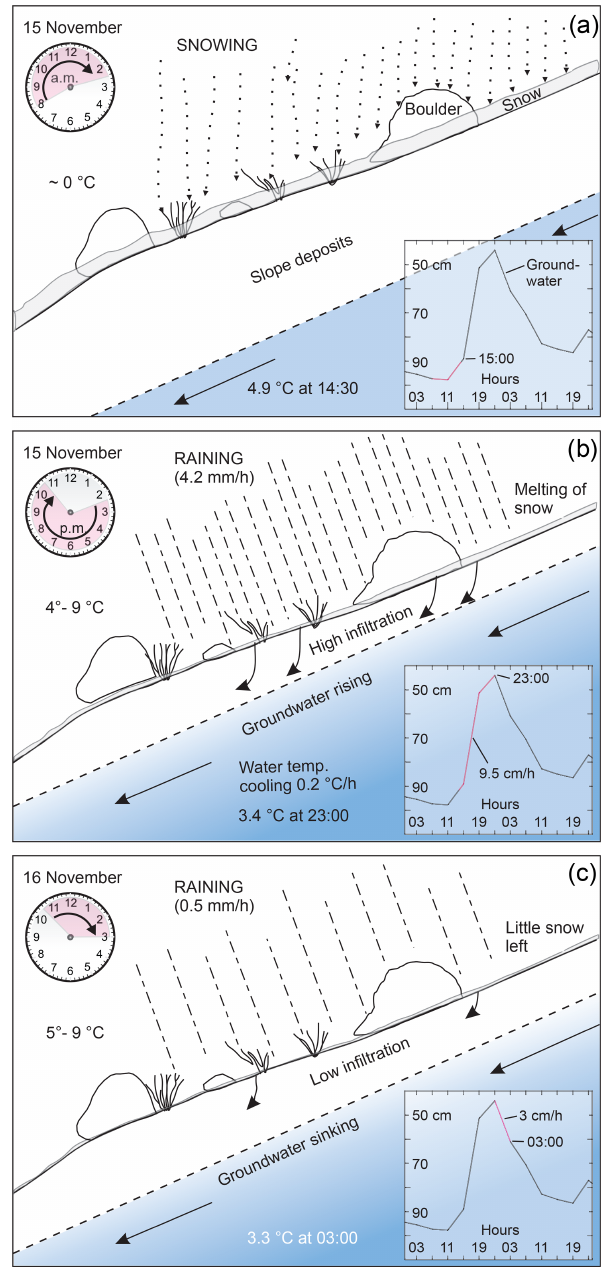
Figure 10. Diagrams to explain the situation on the hillslope during storm Hilde on 15–16 November 2013. The purple section of the clock and purple segment of the groundwater curve in the graph in the lower right corner show the time. (a) Between 08:00 and 14:30, air temperatures were close to 0 ◦ C, and the precipitation fell as snow. Groundwater level was stable (graph in lower right corner). (b) Between 14:30 and 22:30, the air temperature rose to 9 ◦ C, it rained 4.2mm/h, groundwater level rose by 9.5cm/h and ground- water temperatures dropped by 1.6 ◦ C. (c) After 22:30, the heavy rain ceased, and the groundwater dropped by